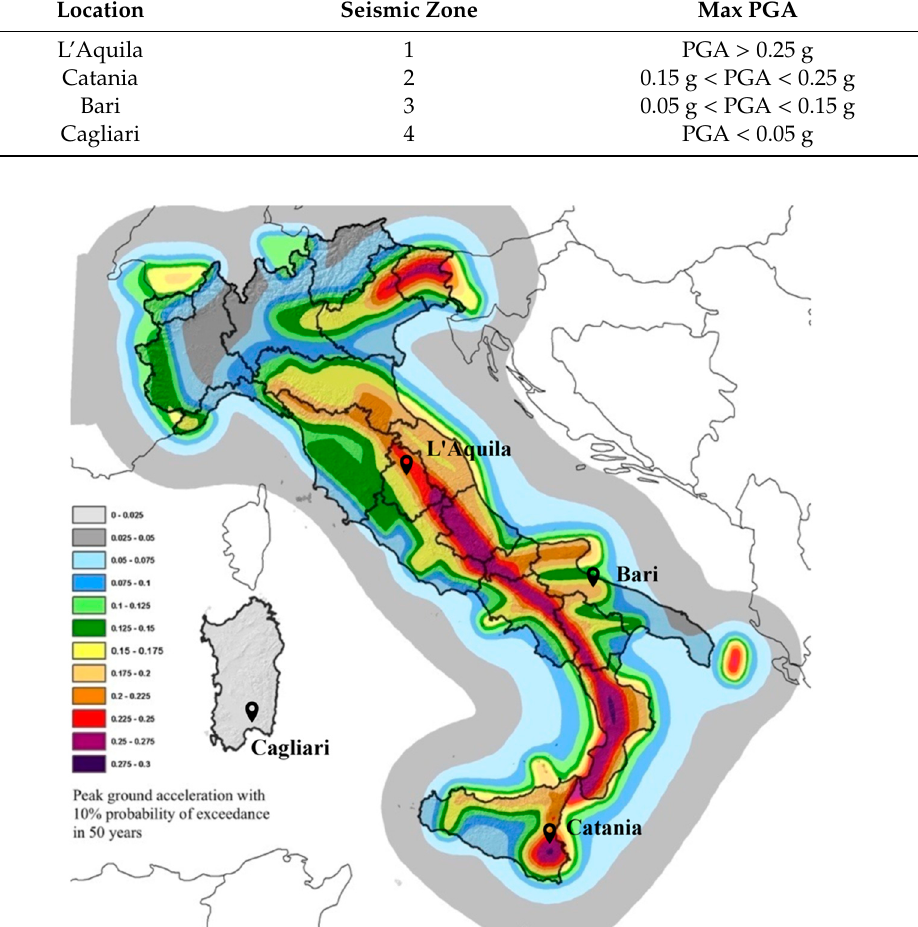
Figure 3. Italian map of seismic PGA (peak ground acceleration), taken from [27] and geographical locations of the four design sites.